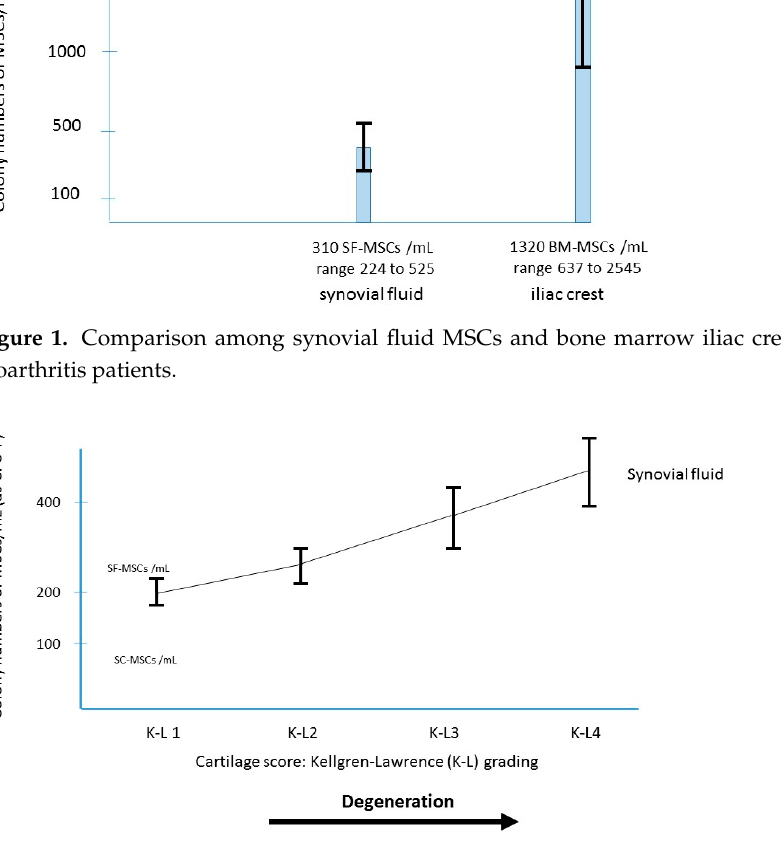
Figure 2. MSCs in synovial fluid derived from osteoarthritis patients. Relationship between the osteoarthritis grading and the colony number of synovial fluid MSCs per synovial fluid volume (mL).